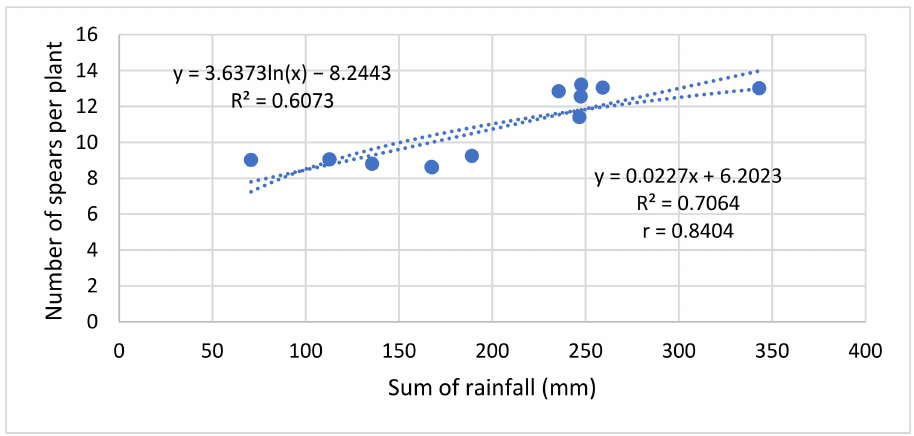
Figure 3. Relationships between the sum of rainfall and irrigation rates in July–August and number of spears per plant of ‘Ravel’. Drip irrigation combined with fertigation, on average for the three tested cultivars and six years of harvest, significantly increased the weight of one green asparagus